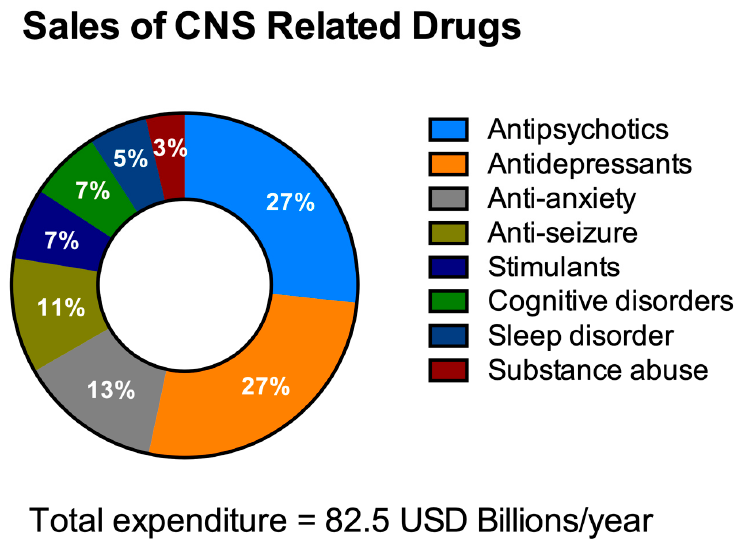
Figure 3. Total expenditure on central nervous system (CNS)-related drugs in 2010. Adapted from Gustavsson et al., 2011 [77].